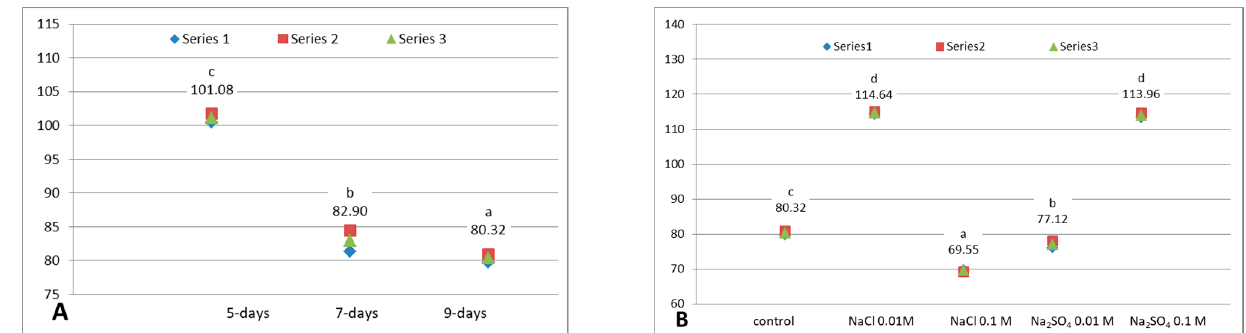
Figure 3. Total reducing capacity (TRC, mg GAE/100 g FW) of white cabbage microgreens. ( A ). Influence of growth: untreated 5-, 7- and 9-day-old microgreens ( α = 0.05, between groups df = 2, F = 363.932 p = 0.000). ( B ). Influence of NaCl or Na 2 SO 4 treatments on 9-day-old microgreens ( α = 0.05, between groups df = 4, F = 3816.965, p = 0.000). Above the data points are displayed the mean values and a letter: different letters denote significant differences between values (Tukey HSD test). Series 1, 2 or 3 from the legend represent the 3 individual experiments.